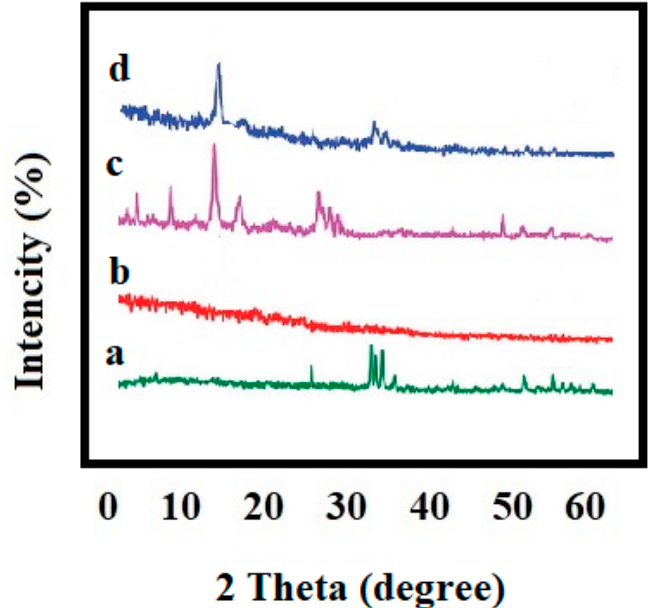
Figure 4. The pattern of X-ray diffraction for nanoparticles of hydroxyapatite ( a ), gelatin ( b ), curcumin ( c ), and hydroxyapatite–gelatin/curcumin nanocomposites ( d ).